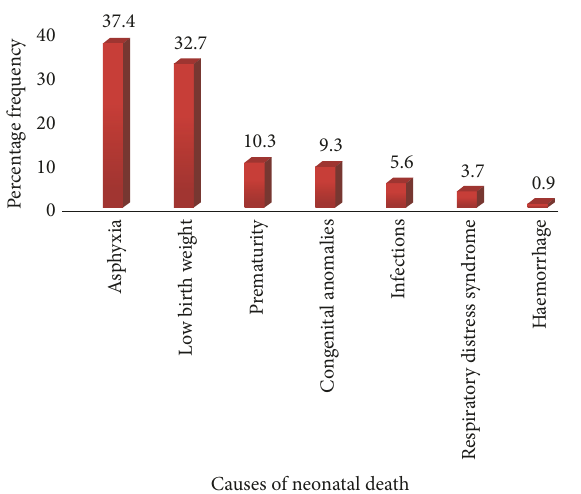
Figure 1: Percentage frequency distribution of causes of death.